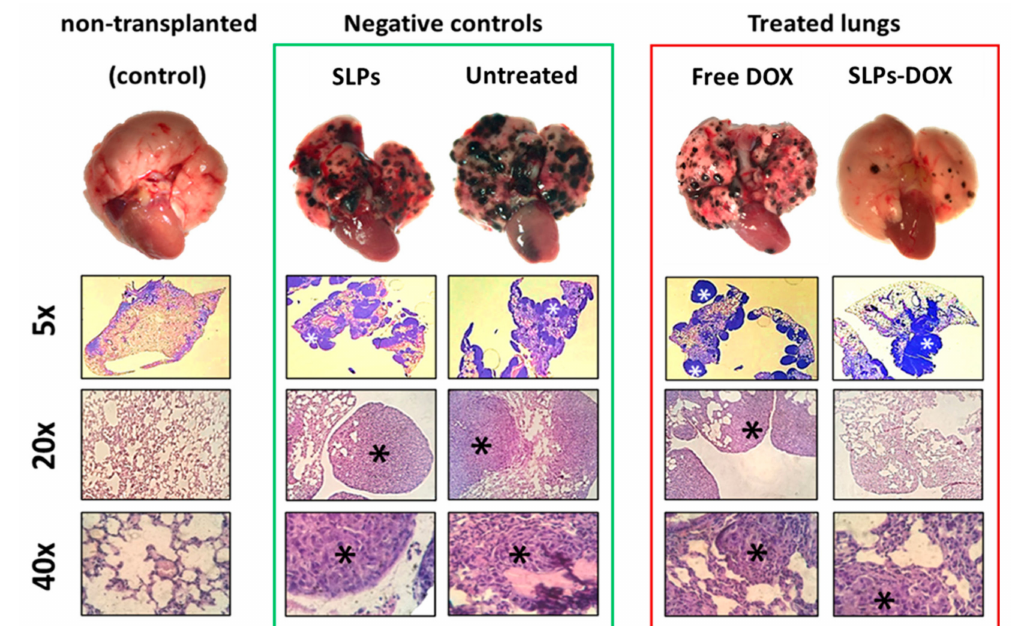
Figure 4. Representative images of metastatic lungs for each experimental group. In the first row, metastatic foci are recognized as black spots on the fresh lung surface. Hematoxylin–eosin-stained histological sections of the lung tissues are shown. Metastatic tissues are indicated by